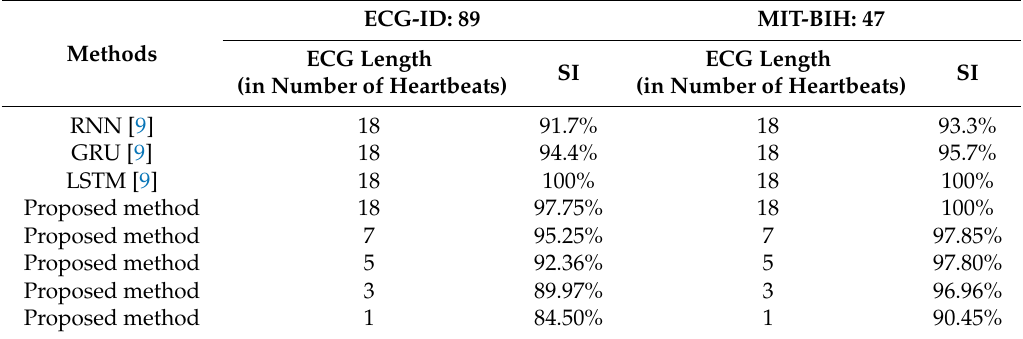
Table 9. Comparison of the proposed method with reference [9] (SI-Subject Identification, HI-Heartbeat